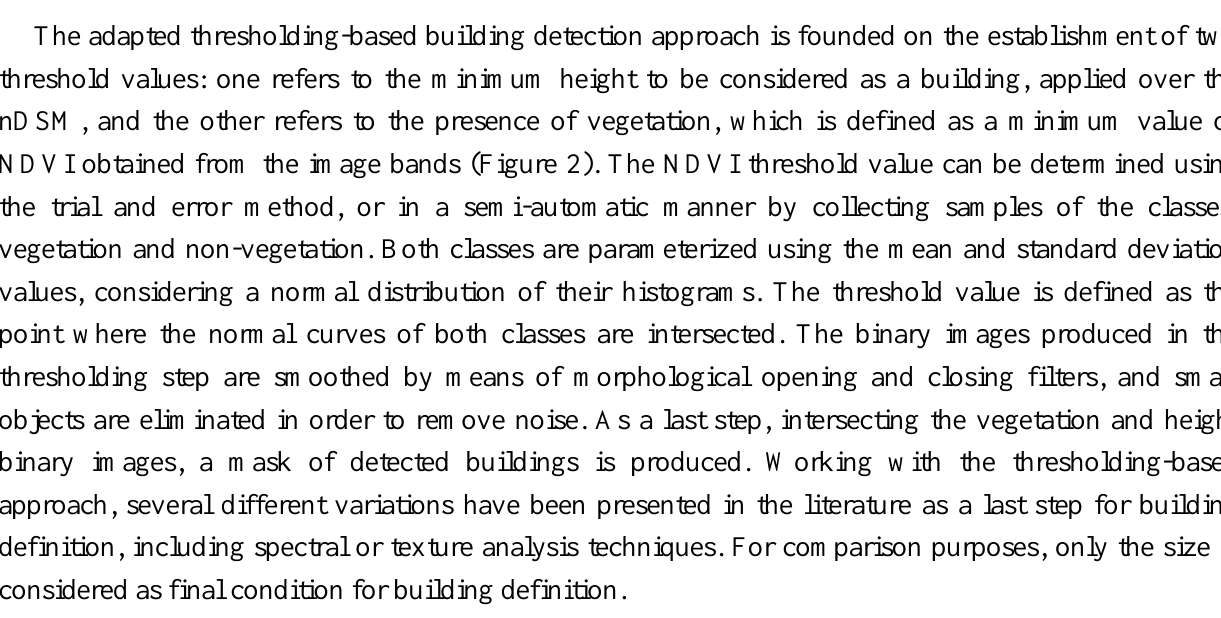
Figure 2. Scheme of the thresholding-based building detection